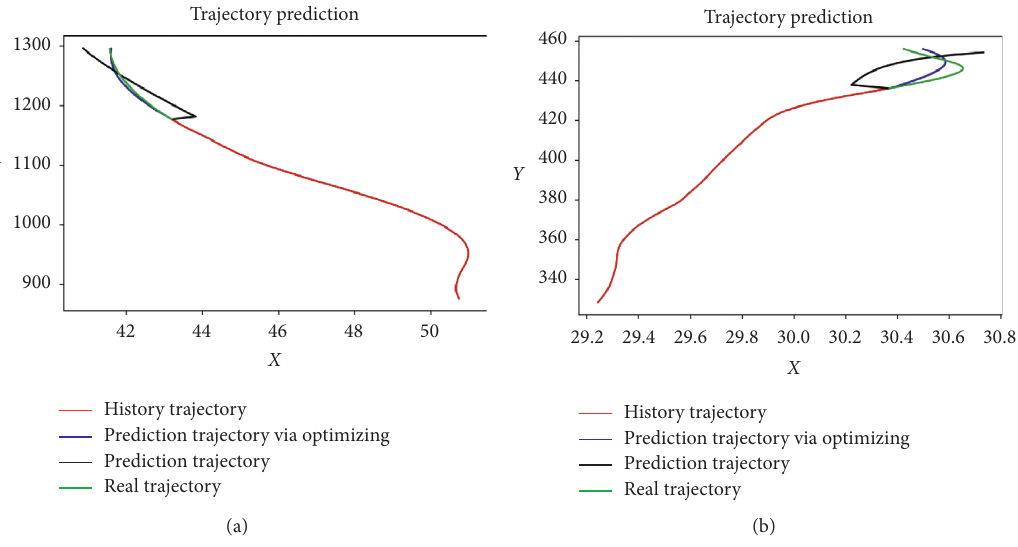
Figure 6: Trajectory prediction results without vehicle behavior. (a) Prediction trajectory 1. (b) Prediction trajectory 2.